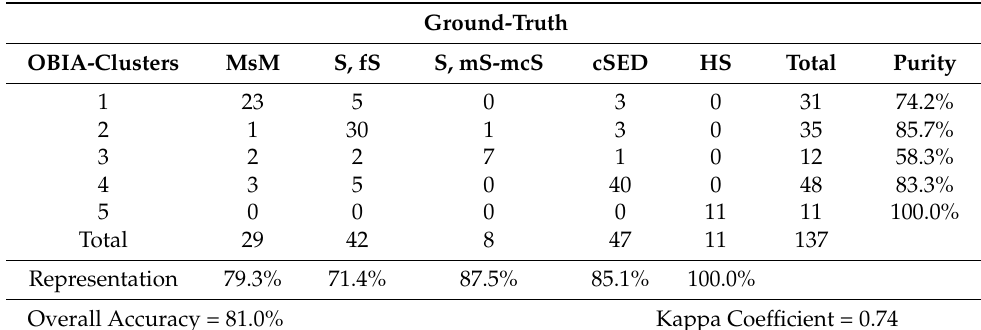
Table 1. Error matrix and accuracy coefficients. The matrix contains the number and type of sediments per cluster. Abbreviations refer to sample classes shown in Figure